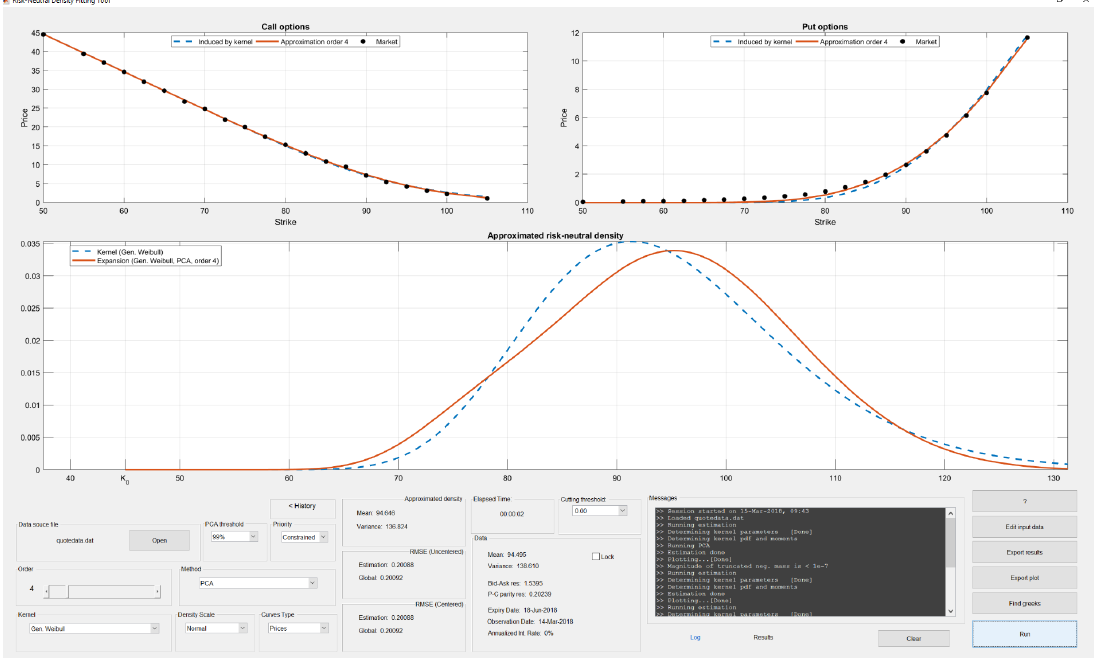
Figure 6. RNDs obtained from Microsoft (MSFT) options observed on 14 March 2018 and with maturity 18 June 2018. Source